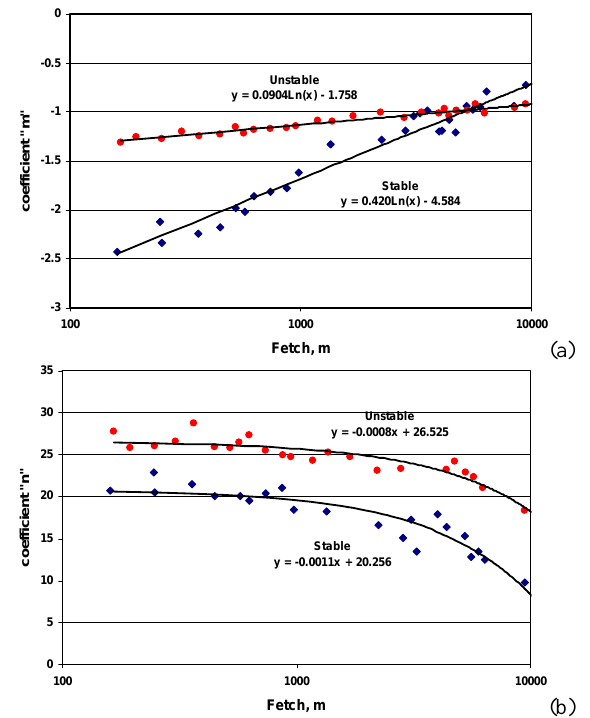
Fig. 6. The coefficients m and n plotted against fetch distance, for stable and unstable conditions.